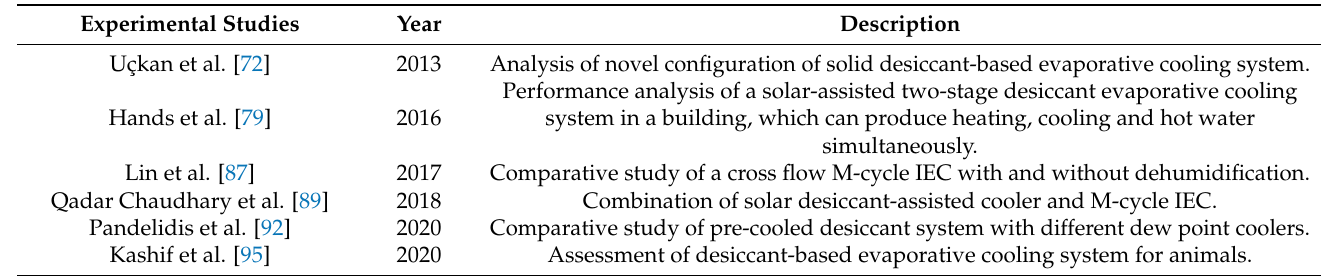
Table 3. Experimental studies of solid desiccant evaporative cooling system.